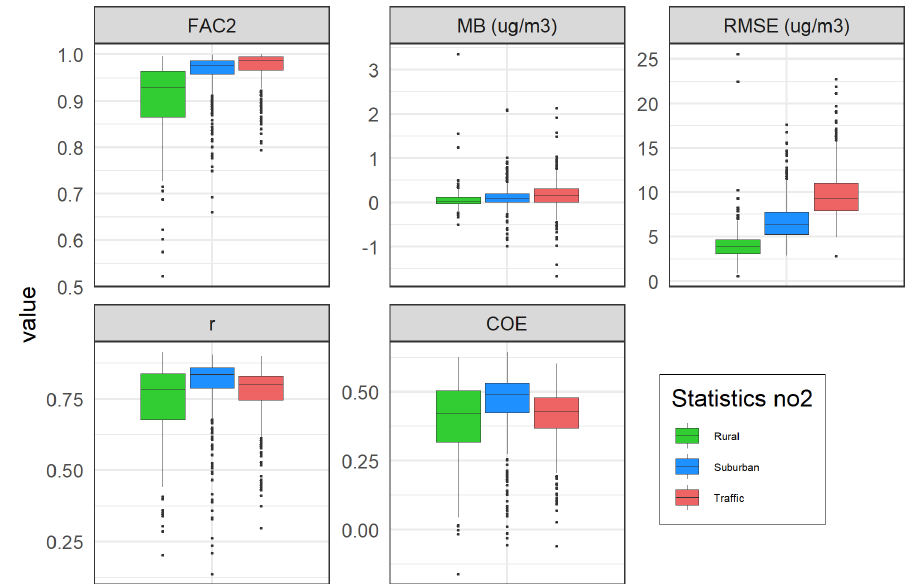
Figure 4. Box plots of some selected evaluation parameters from the cross-validation for 2005–2019, again for the same three categories of stations as in Figs.